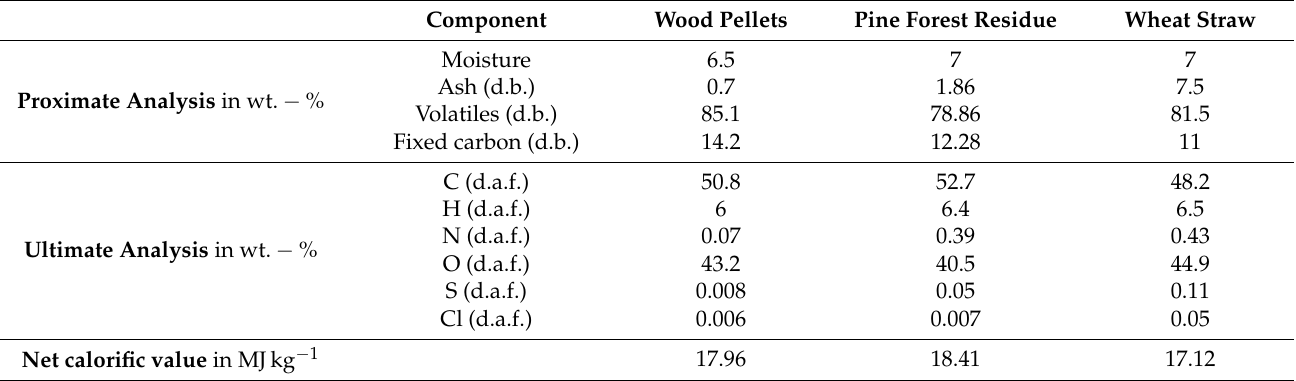
Table 2. Proximate and ultimate analysis of feedstocks. Component Wood Pellets Pine Forest Residue Wheat Straw